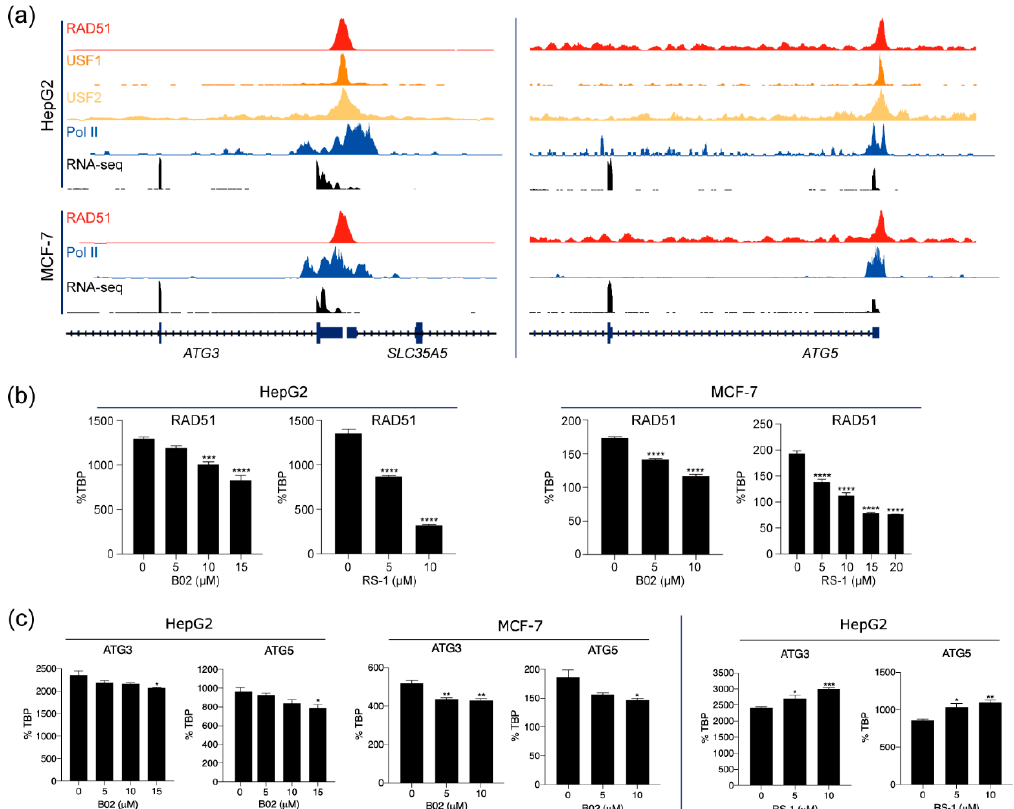
Figure 5. RAD51 is involved in the regulation of autophagy-associated genes in HepG2 and MCF7 cell lines. ( a ) Snapshots of ChIP-seq browser tracks for the ATG3 and ATG5 genes are shown. ( b ) Transcript levels of RAD51 were assessed in HepG2 and MCF-7 cells treated with B02 or RS-1 at different concentrations for 24 h. ( c ) Transcript levels of ATG3 and ATG5 were assessed in HepG2 and MCF7 cells treated with B02 (left) or RS-1 (right) at different concentrations for 24 h. TBP was used for the normalization of each cell line level. * p < 0.05; ** p < 0.01; *** p < 0.001; **** p < 0.0001. The analysis was performed using one-way ANOVA. Data are shown as mean ± SEM.